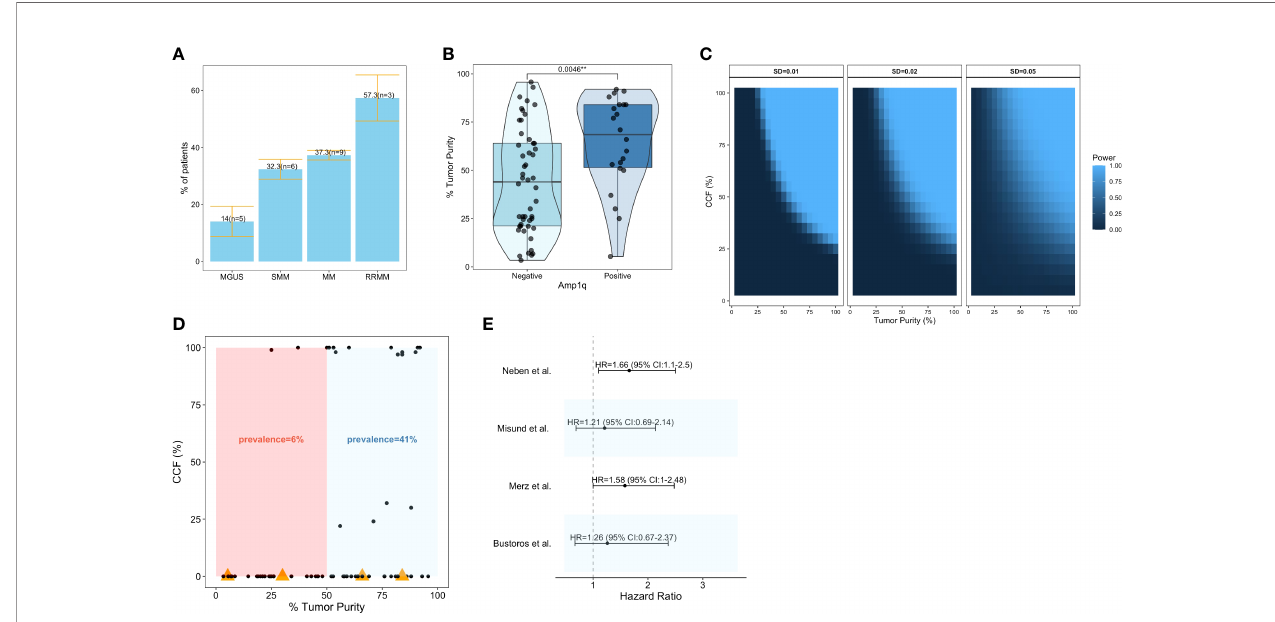
FIGURE 1 | Prevalence and clinical signi fi cance of Amp1q in patients with MM and its precursors. (A) Barplots visualizing the mean ± standard error of the prevalence of Amp1q per disease stage. The number of studies (n) considered in those estimates is also visualized. (B) Boxplots comparing the tumor purity of samples in which Amp1q was detected to those in which it was not detected in Bustoros et al. (8). (C) Power analysis for the detection of arm-level copy number variants in sequencing experiments as a function of tumor purity (x-axis) and the abnormality ’ s cancer cell fraction (CCF). Each panel corresponds to a different standard deviation (SD). (D) Scatterplot of tumor purity (x-axis) and CCF (y-axis) in patients from Bustoros et al. (8). Samples in which Amp1q was not detected by whole-exome sequencing are shown with a CCF of 0. Samples in which Amp1q was not detected by whole-exome sequencing but was detected by fl uorescence in situ hybridization (FISH) are shown with an orange triangle. (E) Forest plot summarizing the impact of Amp1q on the risk of progression from smoldering multiple myeloma to overt disease in four studies. Its effect is visualized as a hazard ratio with a 95% con fi dence